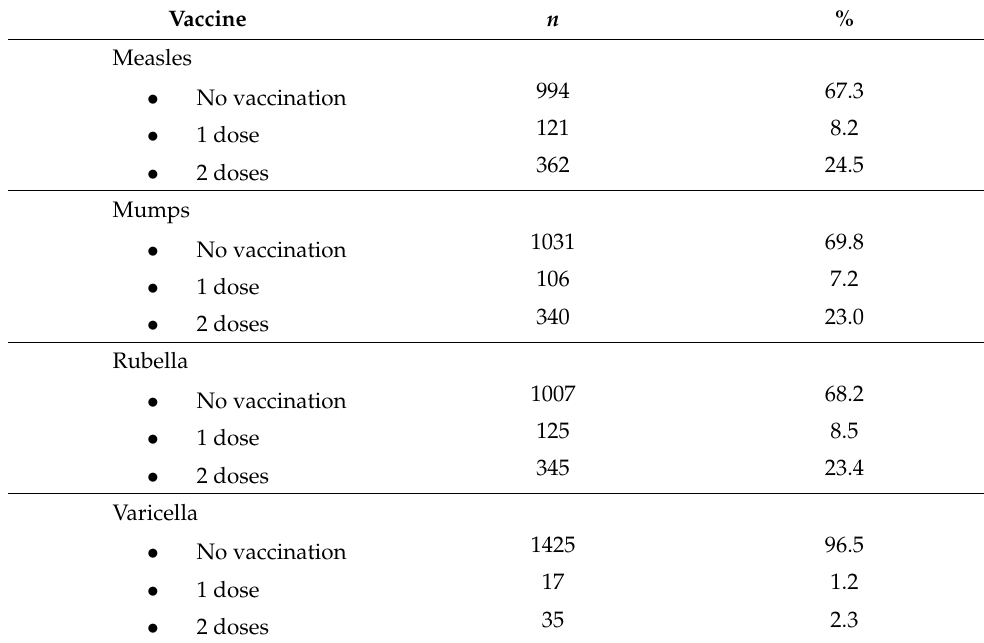
Table 2. Immunization status of healthcare workers ( n = 1477) per vaccine type.